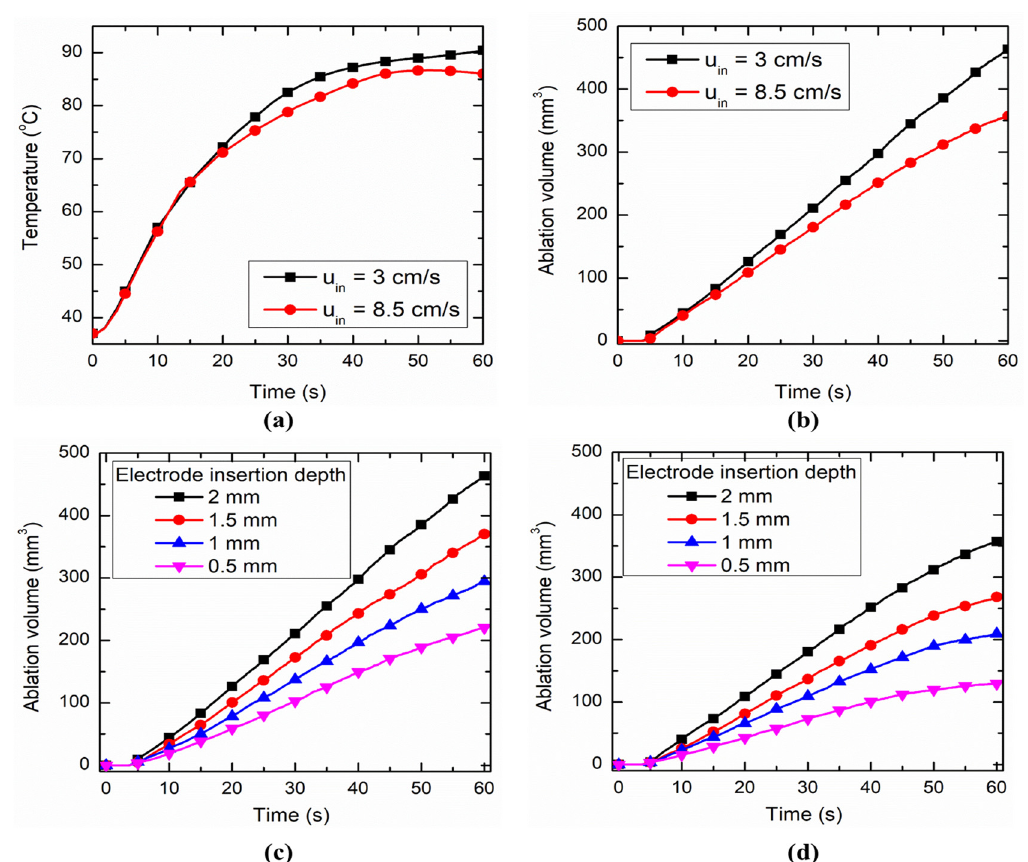
Figure 5. Temporal variation of: ( a ) temperature at a point 1 mm away from tip of electrode, and ( b ) ablation volume for different values of blood flow rates. ( c ) Comparison of ablation volumes predicted with different insertion depth of the electrodes for low blood flow rate and ( d ) high blood flow rate conditions.